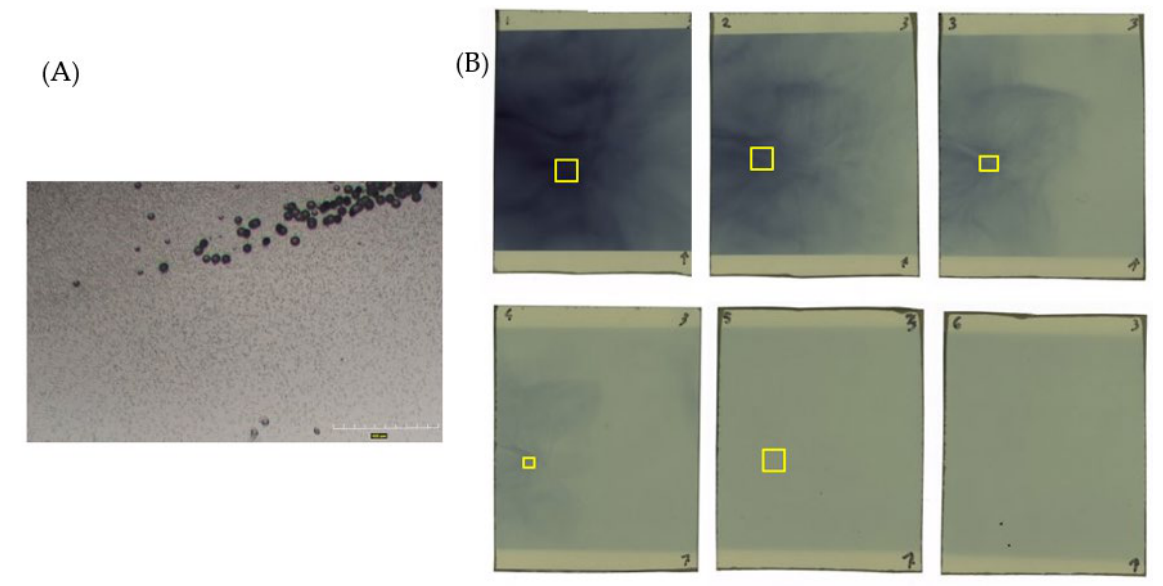
Figure 22. Detailed view of a CR-39 after a partial etching process ( A ) where the ion tracks are visible, and a set of radio-chromic films ( B ) are irradiated in stack configuration (the yellow squared region marks the ROI used for dose calculation).